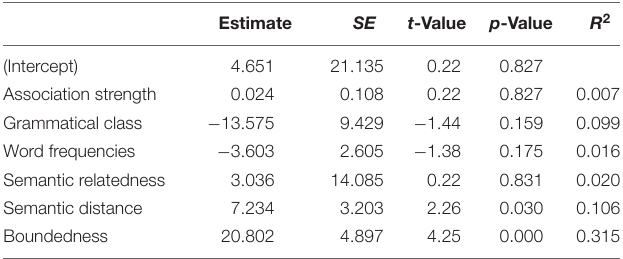
TABLE 1 | Results of multiple linear regression for inference ratings of Experiment 1.